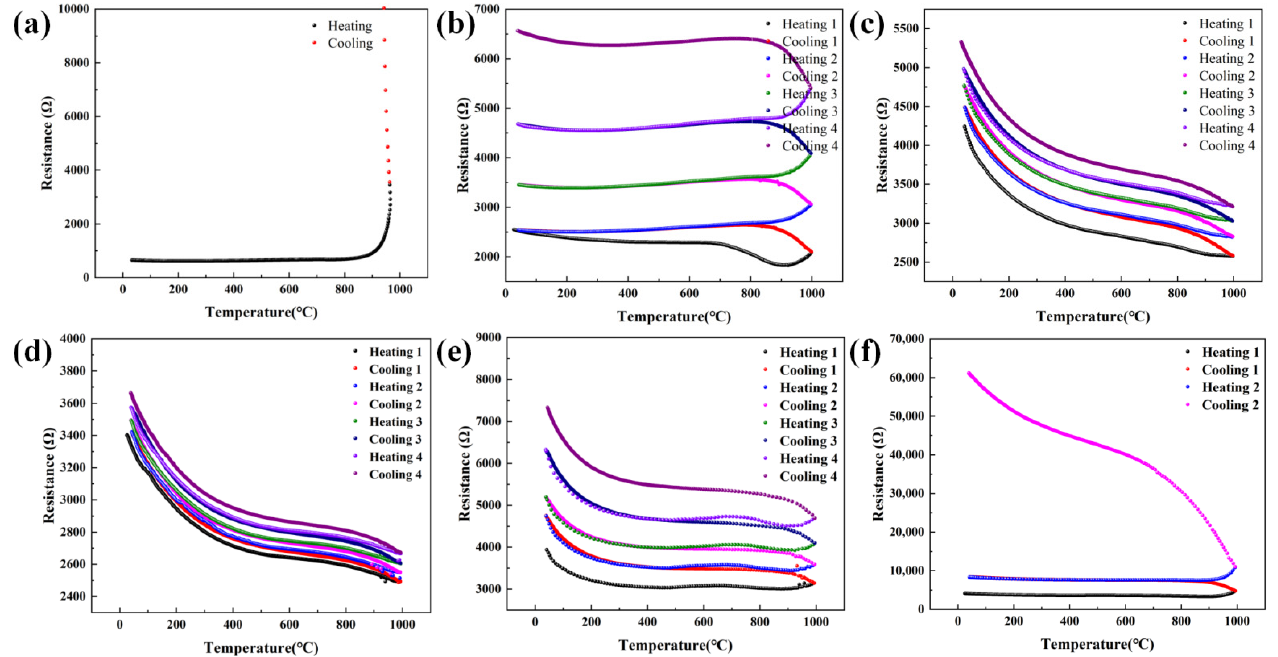
Figure 6. R–T curves of TiB 2 /SiCN resistive grids: ( a ) without protective layer, ( b ) with SiCN protective layer, ( c ) with Al 2 O 3 (10 wt%)/SiCN protective layer, ( d ) with Al 2 O 3 (20 wt%)/SiCN protective layer, ( e ) with Al 2 O 3 (30 wt%)/SiCN protective layer, and ( f ) with Al 2 O 3 (40 wt%)/SiCN protective layer.